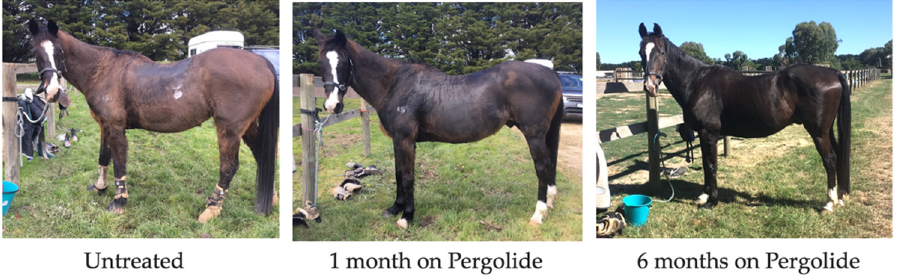
Figure 4. 18-year-old Irish Sport Horse clipped coat untreated; after one month of pergolide, and after six months of pergolide.